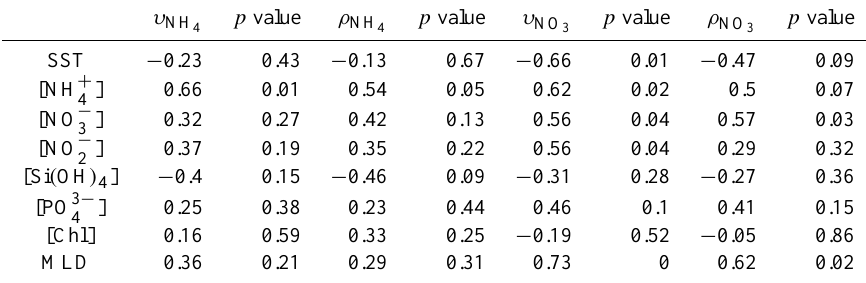
Table 3. Spearman correlation matrix of uptake rates and environmental variables for the summer cruise with the associated p values. υ NH and υ NO are the specific ammonium and nitrate uptake rates while ρ NH 4 3 surface temperature and MLD (mixed layer depth) the mixed layer depth. [NH + concentrations of ammonium, nitrate, nitrite, silicic acid, phosphate and chlorophyll. υ NH p 4